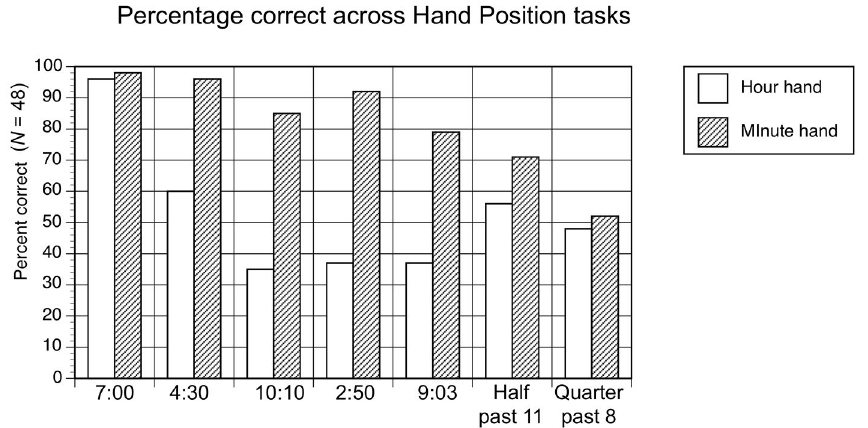
Figure 3. Performance across Hand Position tasks for both hour and minute